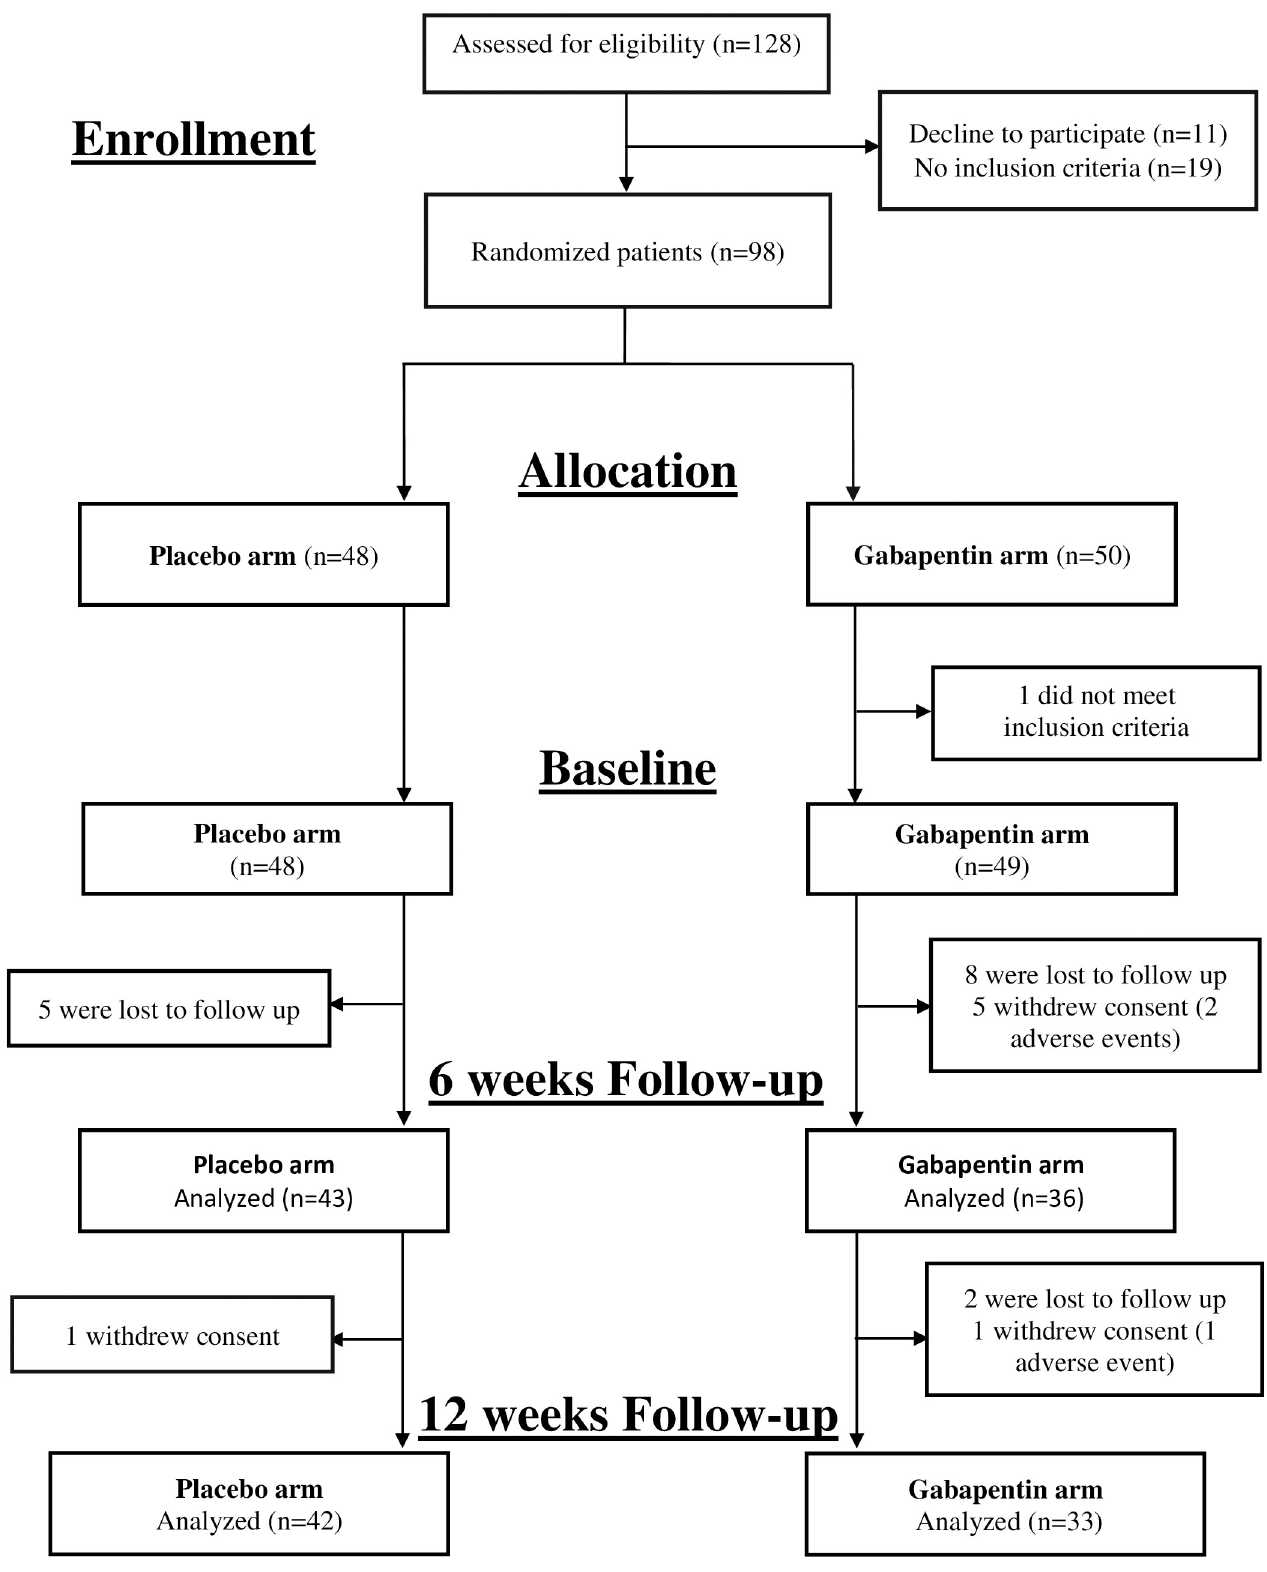
Fig 1. Study design and patient disposition (CONSORT flow diagram).